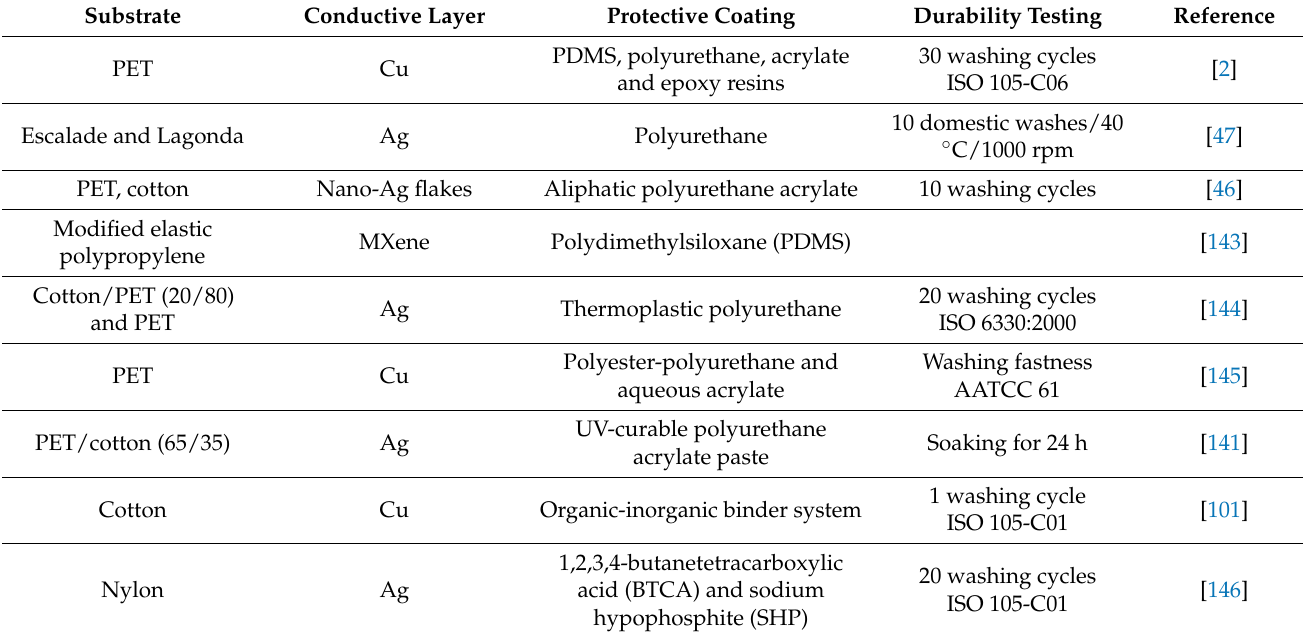
Table 2. Overview of protective coatings on metallized textiles and wash durability